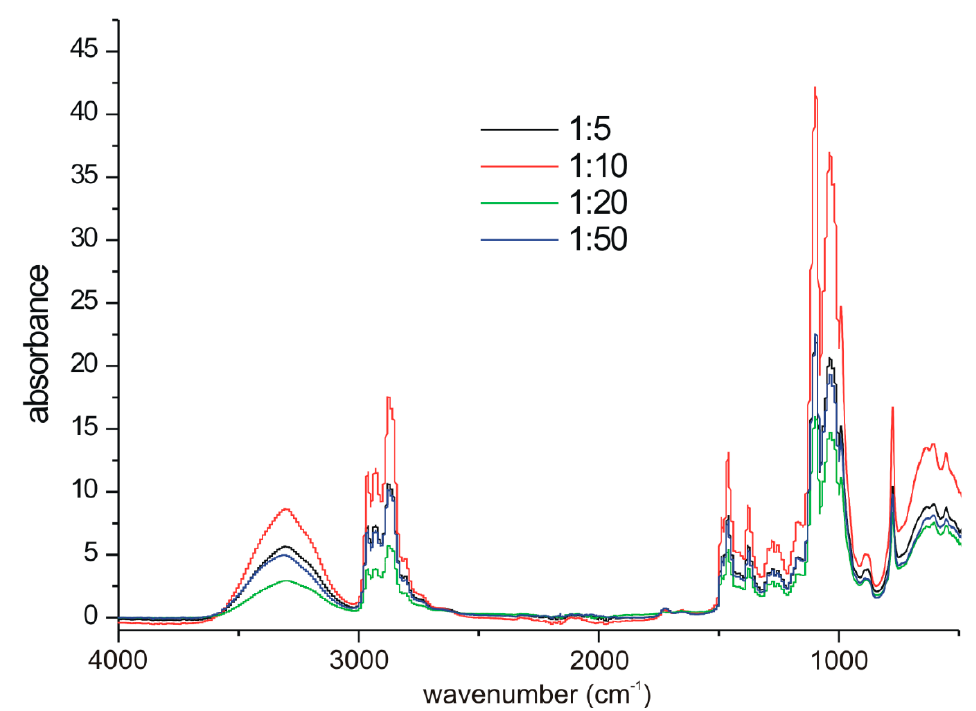
Figure 5. FTIR spectra of poly(3-ethyl-3-(hydroxymethyl)oxetanes).